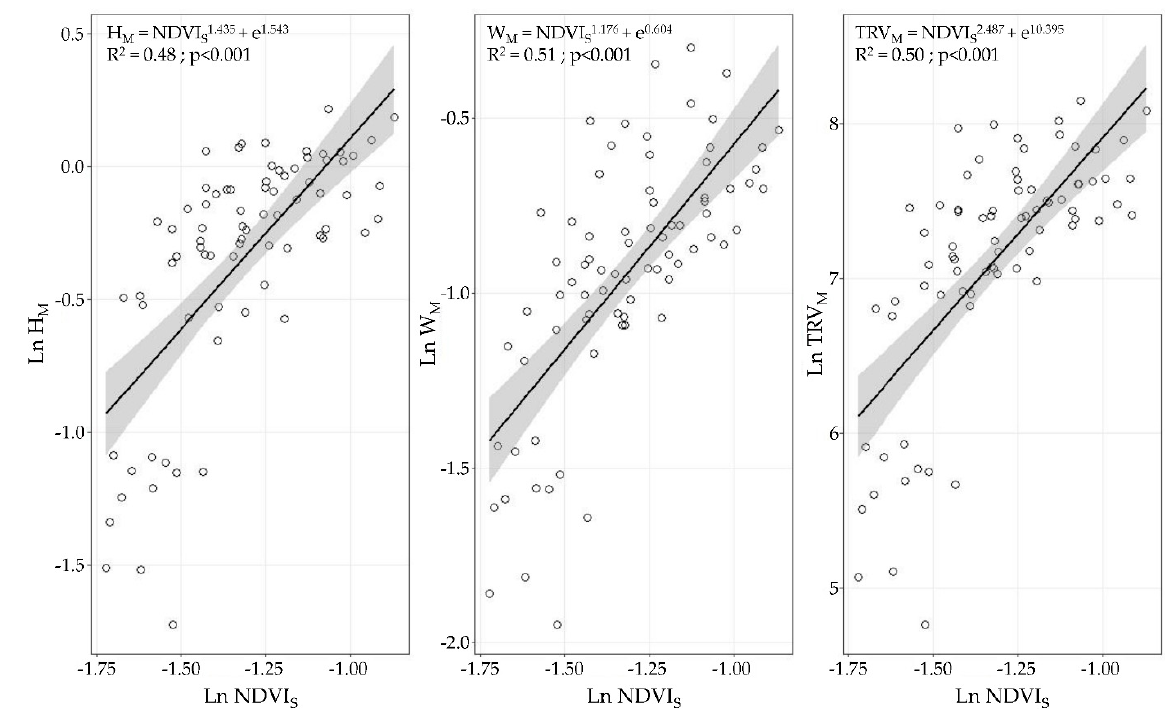
Figure 10. Linear regression models evaluating relationships among Ln NDVI S and transformed canopy structural parameters (Ln H M , Ln W M , and Ln TRV M ). Grey bands present 95% confidence interval.